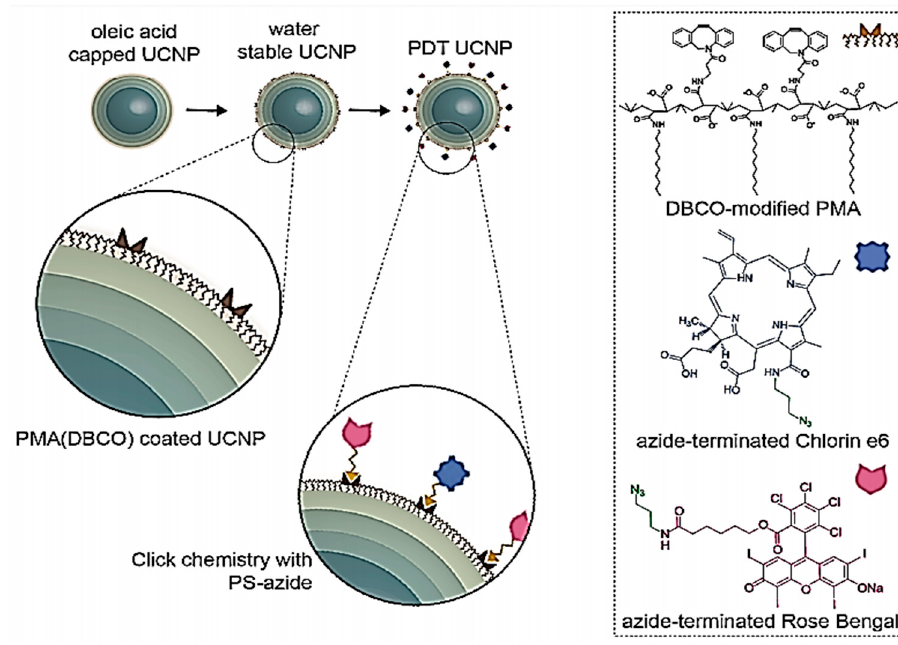
Figure 1. Depiction of the synthetic stages for the synthesis of UCNPs, their water exchange and two PSs functionalization (Rose Bengal and Chlorin e6). Reproduced from [232] with permission from Springer Nature, 2020.